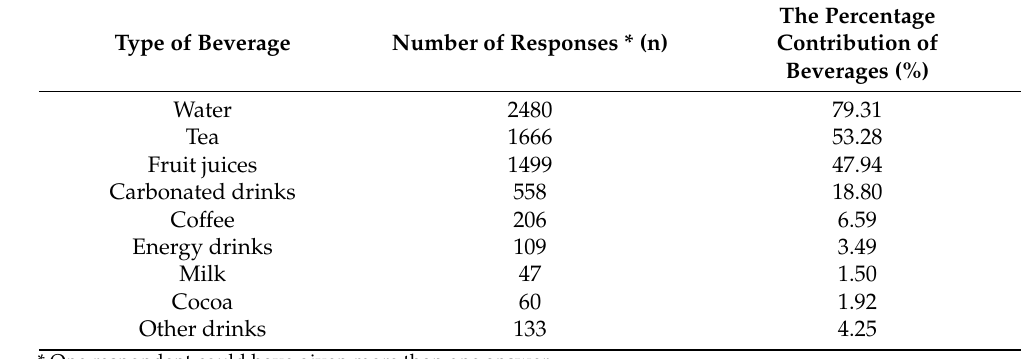
Table 5. Types of beverages while using electronic devices.